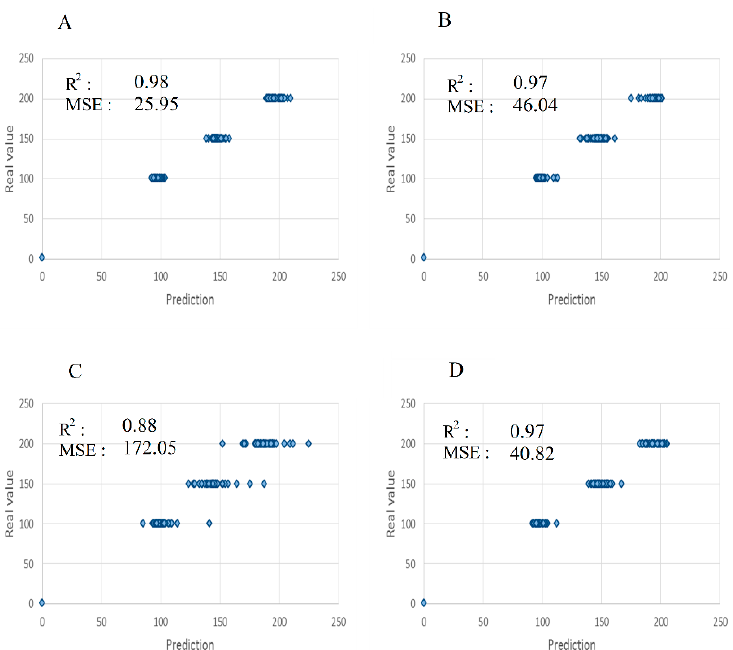
Figure 17. The real values of plasma RF power (Watts) during the sputtering process are presented in ‘y axis and the predicted values in ‘x axis, along with R-squared (R2), and mean squared error (MSE) values of the model’s prediction. ( A ) Original min max scaled spectral data turned into a 2D matrix, ( B ) SOM generated image, ( C ): SOM_SVD generated image from the first layer singular value decomposition reconstruction of the original data, ( D ) Original_SVD image generated from the first layer of the singular value decomposition reconstruction. Out of all the results, we can see that the SVD reconstruction of the SOM model (SVDS) produced the least accurate predictions. The original stack-overlay method of reconstructing a two-dimensional array from the one-dimensional array of the spectra seems to be sufficient for training the CNN model for accurate predictions. When the model was used as a classifier rather than a regressor to predict the presence of hydrogen impurity and impurity in the indium-oxide-based target, we obtained excellent results with all forms of two-dimensional conversion techniques, as presented in Figures 18 and 19. The accuracy metrics associated with the hydrogen presence and indium-oxide target purity are presented in Table 1, Presenting the accuracy metrics of the CNN model’s performance trained with images formed from the four methods of two-dimensional image formation; presence of hydrogen in the working gas and impurity in the indium-oxide target.